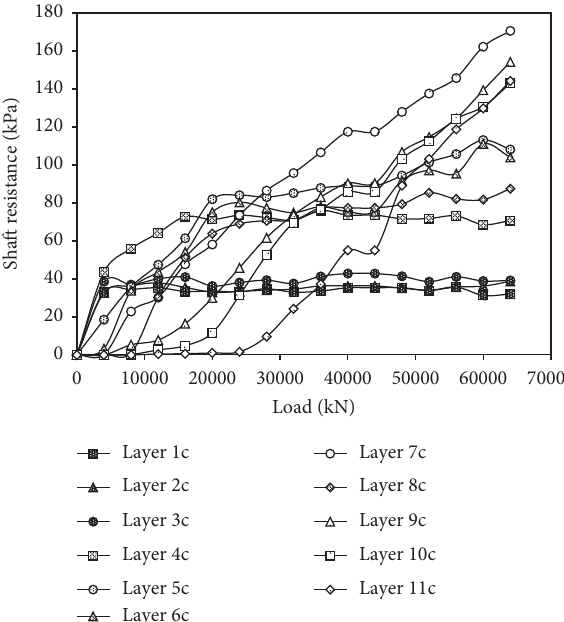
Figure 17: Shaft resistance development of P105.